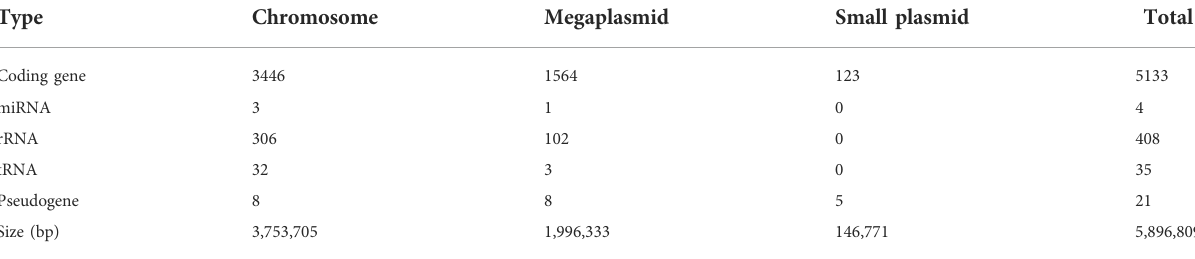
TABLE 1 Statistical results of genomic characteristics of FJ1003